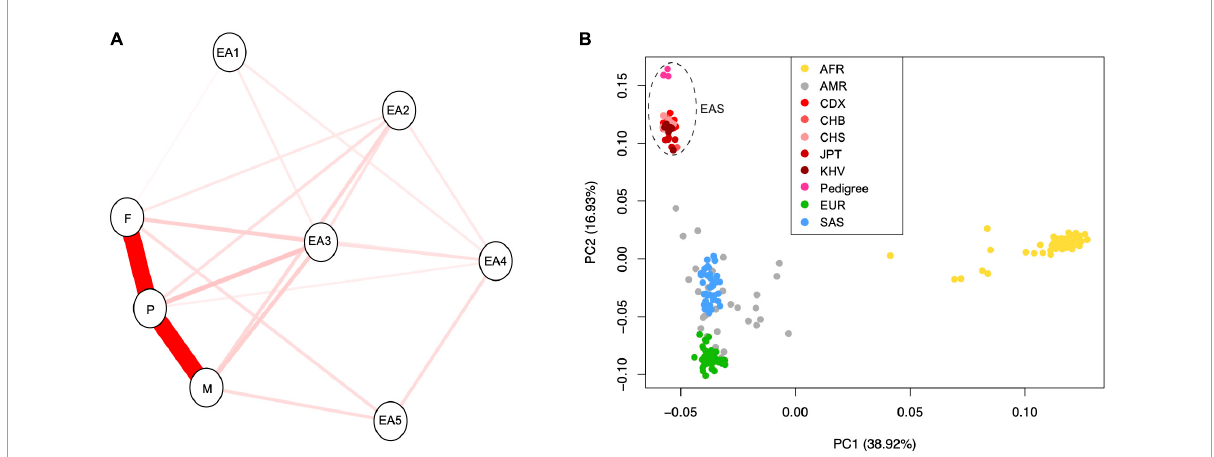
FIGURE2 (A) The identity-by-state (IBS) relationship between newly sequenced pedigree samples and randomly chosen individuals with East Asian ancestry from “1,000 genome” project. (B) The principal component analysis (PCA) for three samples in this study and 208 publicly available individuals from 26 population of the 1,000 genome project. The “EA” indicates “East Asian population.” The populations AFR, AMR, CDX, CHB, CHS, JPT, KHV, EUR, and SAS represent African, Admixed American, Chinese Dai in Xishuangbanna, Han Chinese in Beijing, Southern Han Chinese, Japanese in Tokyo, Kinh in Ho Chi Minh City, European, and South Asian,